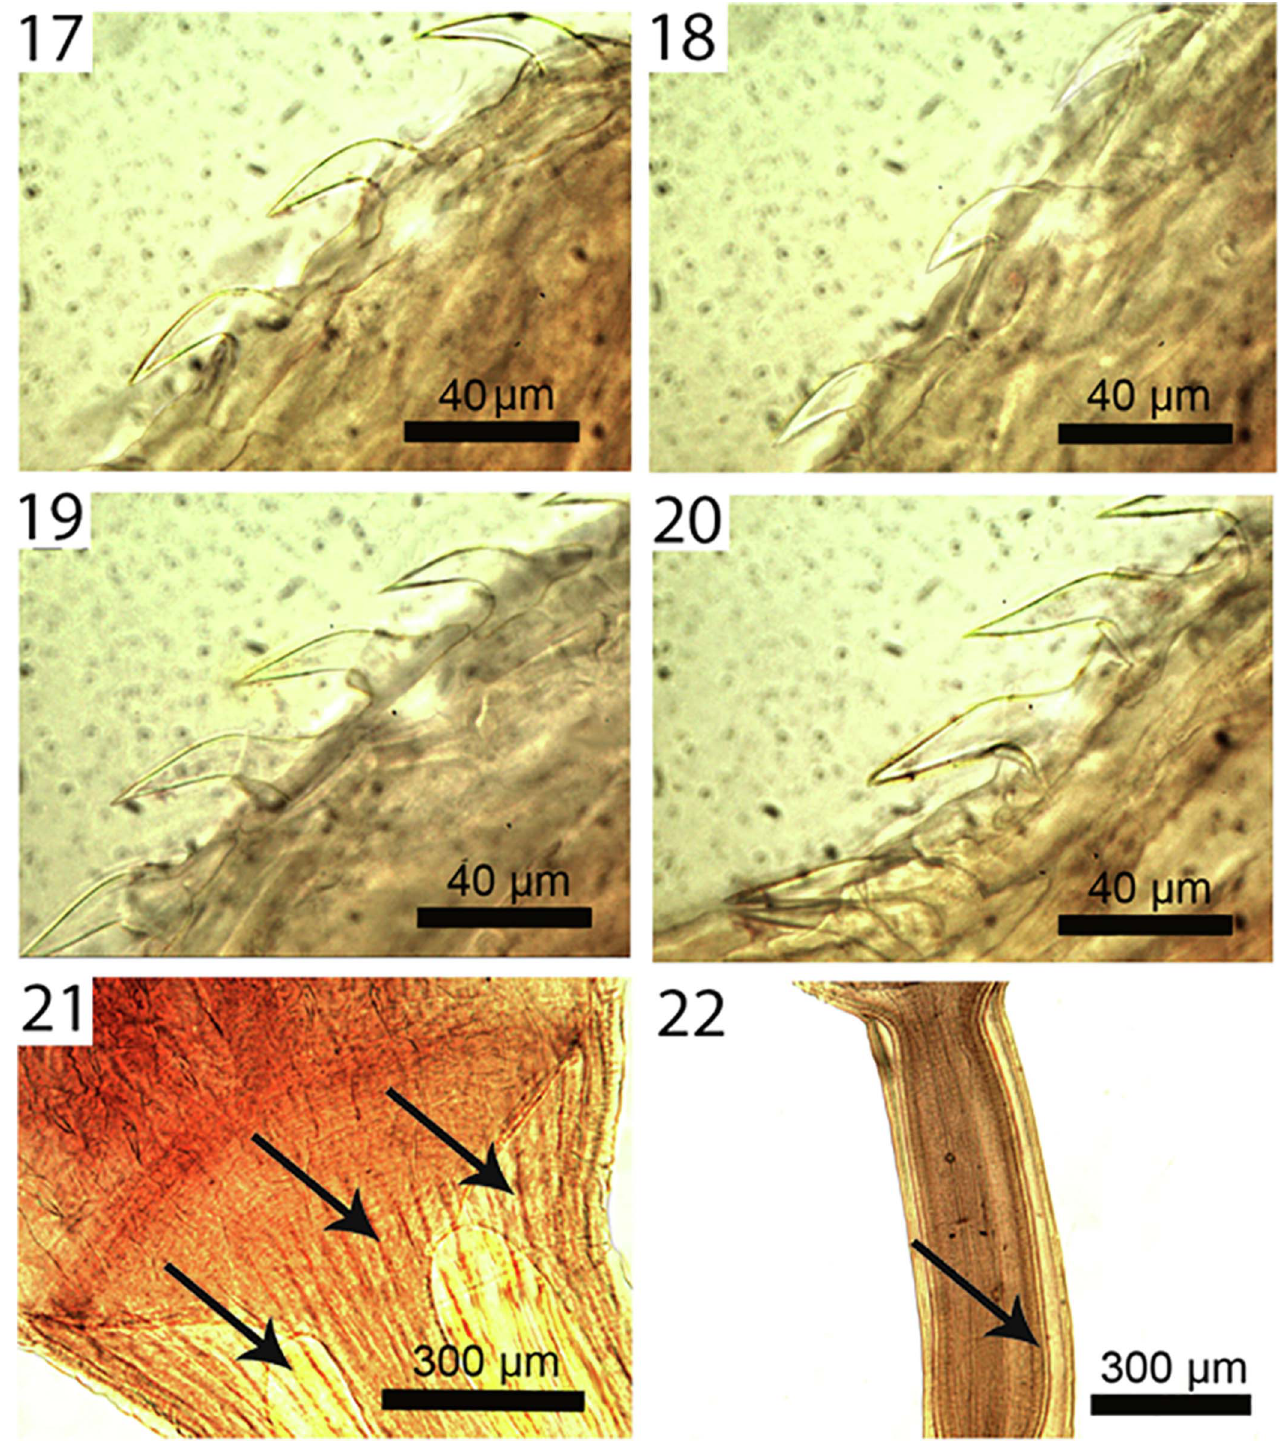
Figures 17 – 22. Micrographs of cystacanths and adults of Pro fi licollis altmani from Emerita analoga and from Larus belcheri , respectively on the Peruvian coastline, Lima. 17 – 20. Lateral views of hooks and roots of one longitudinal row on the proboscis of a cystacanth. 17. Apical and 2 subapical hooks and roots. 18. Hook nos. 4, 5, and 6 with their roots. Note the shorter and thickest hook no. 5 (at middle). 19. Hook nos. 7 – 10; note the increasing size of hooks posteriorly. 20. Hook nos. 11 – 15. Note the increasing size of hooks posteriorly being longest and more crowded basally. 21. Fan shaped anterior end of proboscis receptacle inserted at the posterior end of the proboscis. Note the heavy muscular fi bers of the neck (arrows). 22. Double-walled proboscis receptacle (arrow) within the neck of an adult specimen directly posterior to attachment to